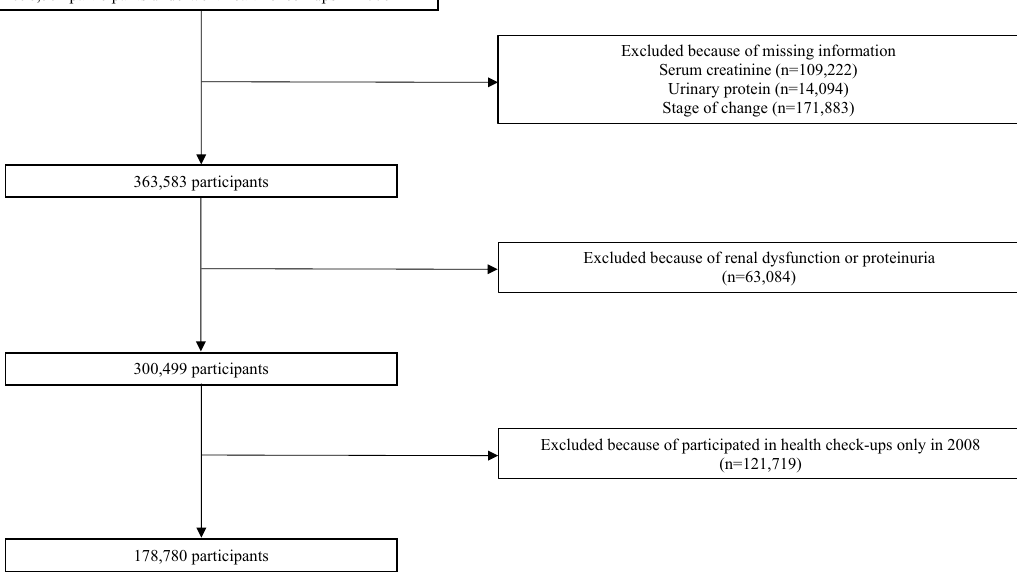
Figure 1. Flow chart showing the selection of the study